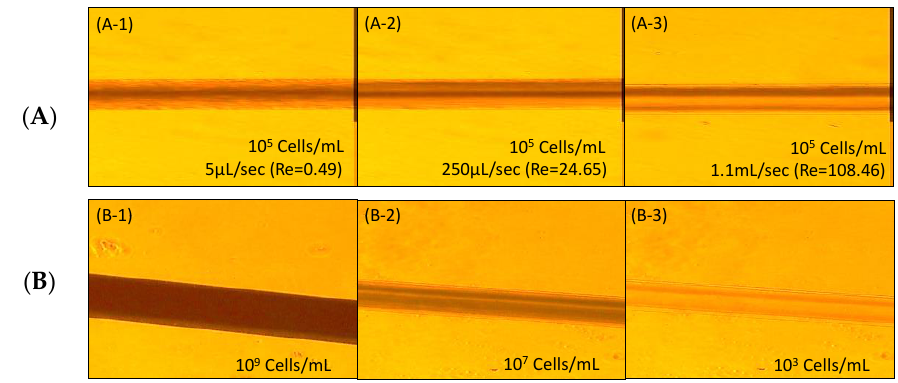
Figure 5. Inertial migration effect in whole blood separation ( A ) with different flow rate, and ( B ) with different blood cells concentration.